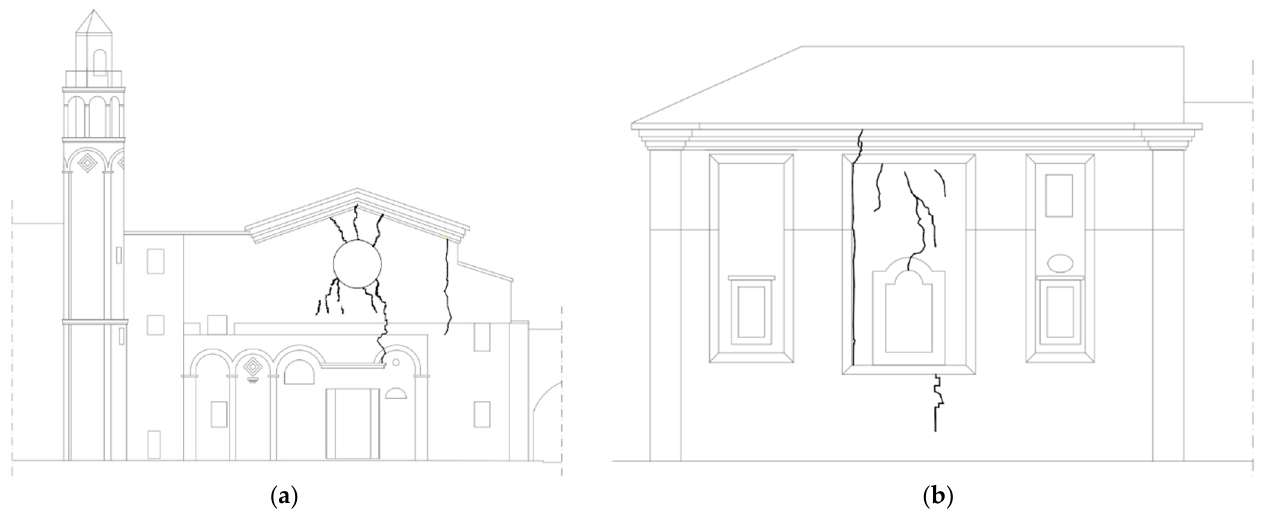
Figure 16. Graphic representation of the crack pattern on the façades: ( a ) main façade; ( b ) rear façade.